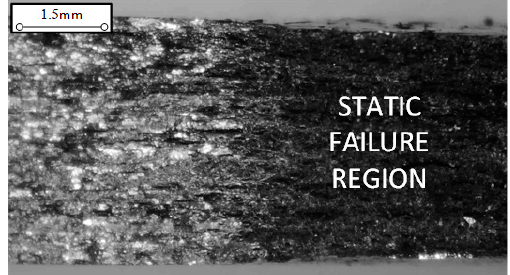
Figure 10. Macroscopic view on the fracture surface of the broken CT specimen (R = 0.5)—fatigue and static fracture surface. Table 4. Values of da/dN- Δ K, Δ K eff curves parameters— C , m under R = 0.05 and 0.5 conditions.